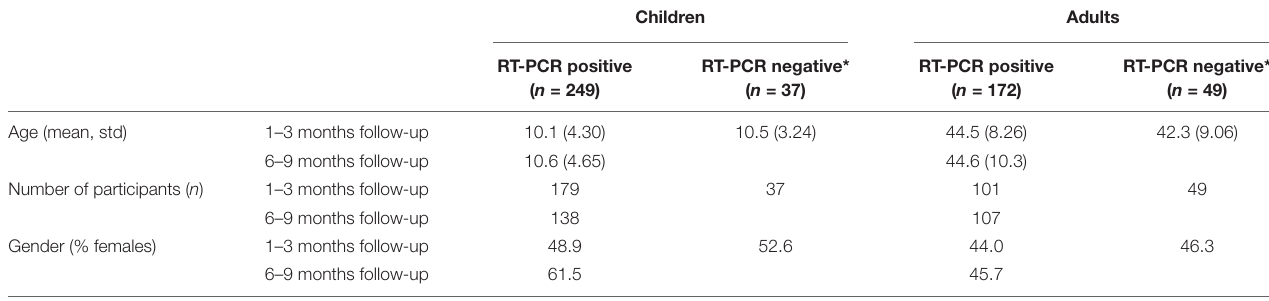
TABLE 1 | Study population.